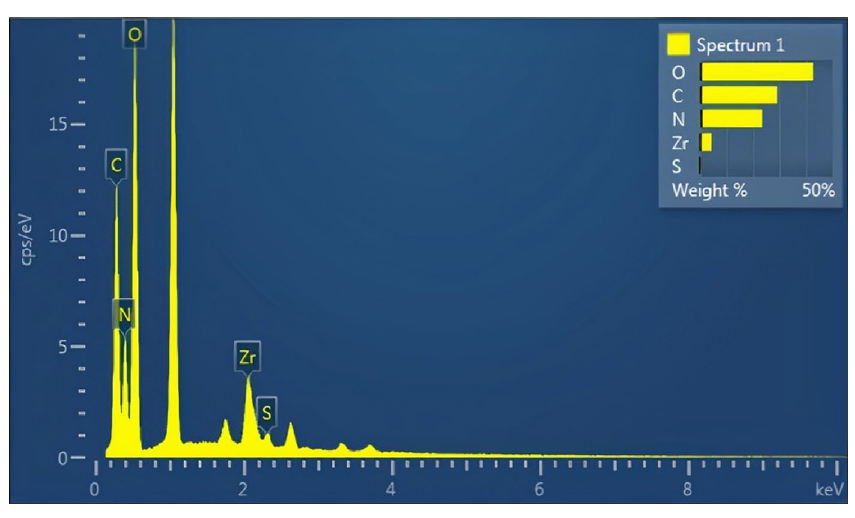
Figure 7. EDX analysis of Fe 3 O 4